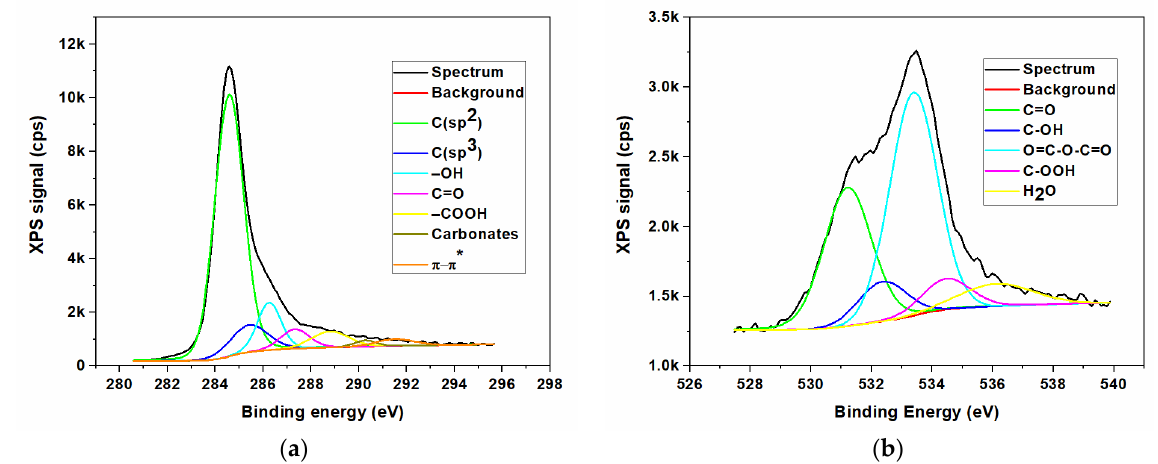
Figure 3. XPS high resolution spectra for non-doped graphene oxide (GO); ( a ) Carbon (C1s); ( b ) Oxygen (O1s).